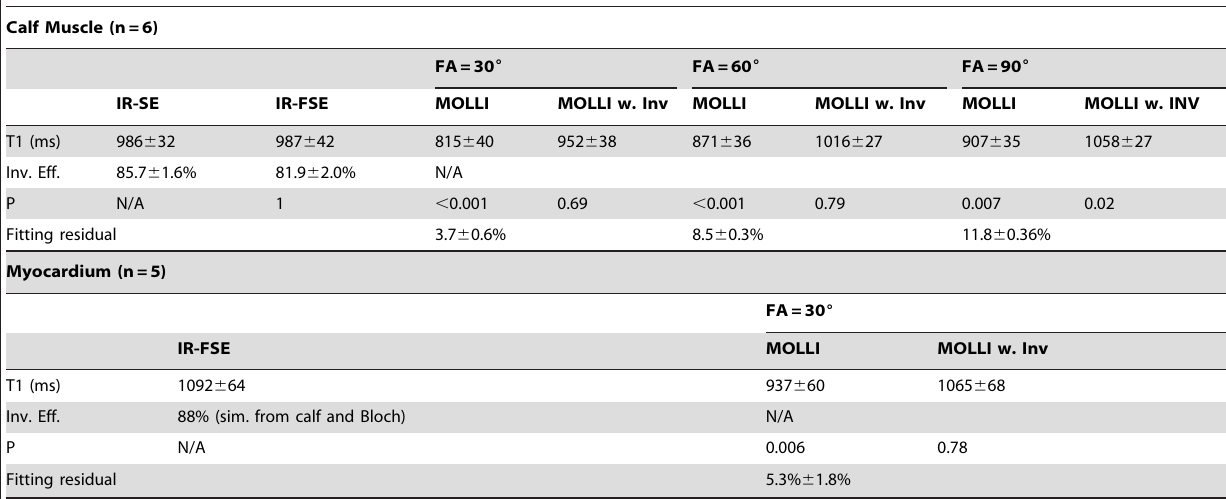
P values are given for comparison with the gold standard IR-SE method (calf) or IR-FSE method (myocardium).